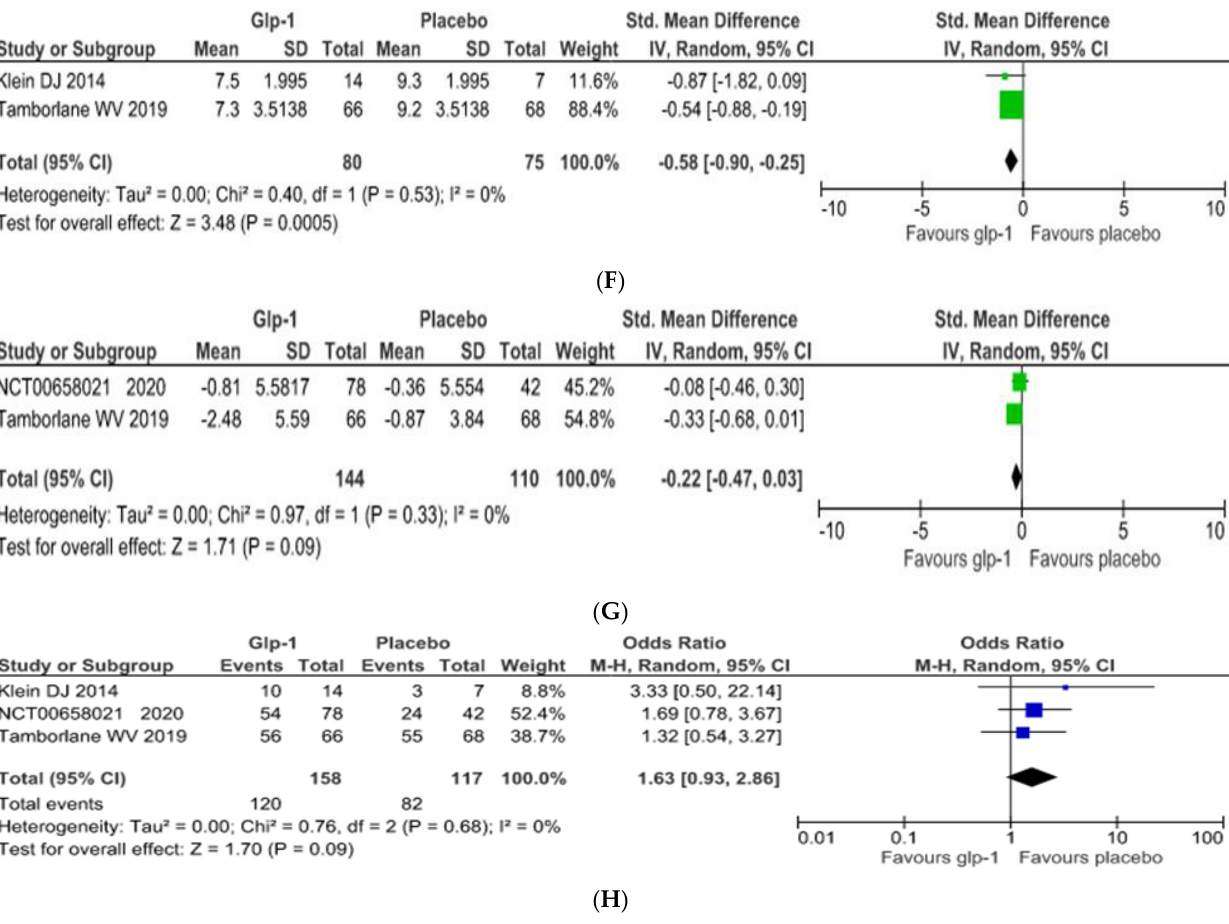
Figure 2. Forest plot comparisons of metformin or liraglutide or exenatide versus placebo, glimepiride, and rosiglitazone . ( A ) Outcome: HbA1c values ( B ) Outcome: fasting plasma glucose ( C ) Outcome: BMI ( D ) Outcome: adverse events ( E ) Outcome: HbA1c values ( F ) Outcome: fasting plasma glucose ( G ) Outcome: BMI ( H ) Outcome: adverse events.